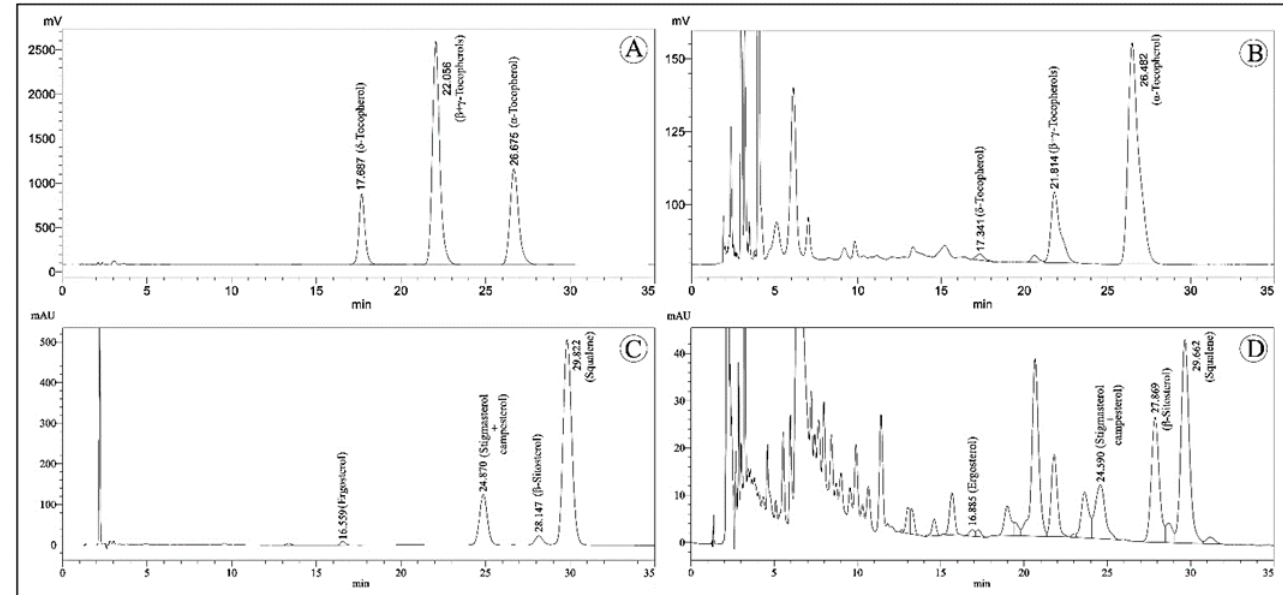
Figure 2. HPLC chromatograms of tocopherol and phytosterol analysis—( A ) Tocopherol standards; ( B ) Tocopherols in seed oil; ( C ) Phytosterol standards; ( D ) Phytosterols in seed oil. Table 3. Physicochemical characteristics of Balanites roxburghii seed oil.